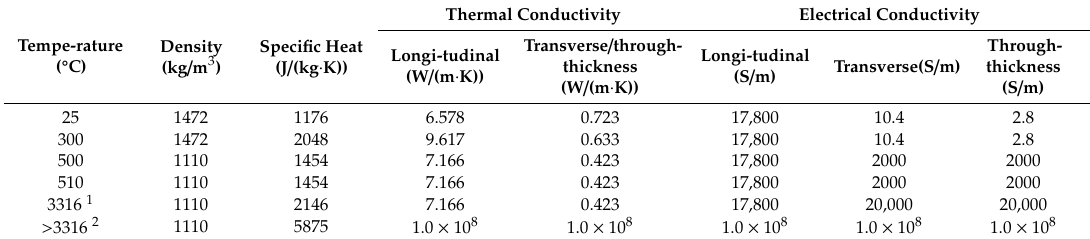
Table 1. Physical properties of the specimen.